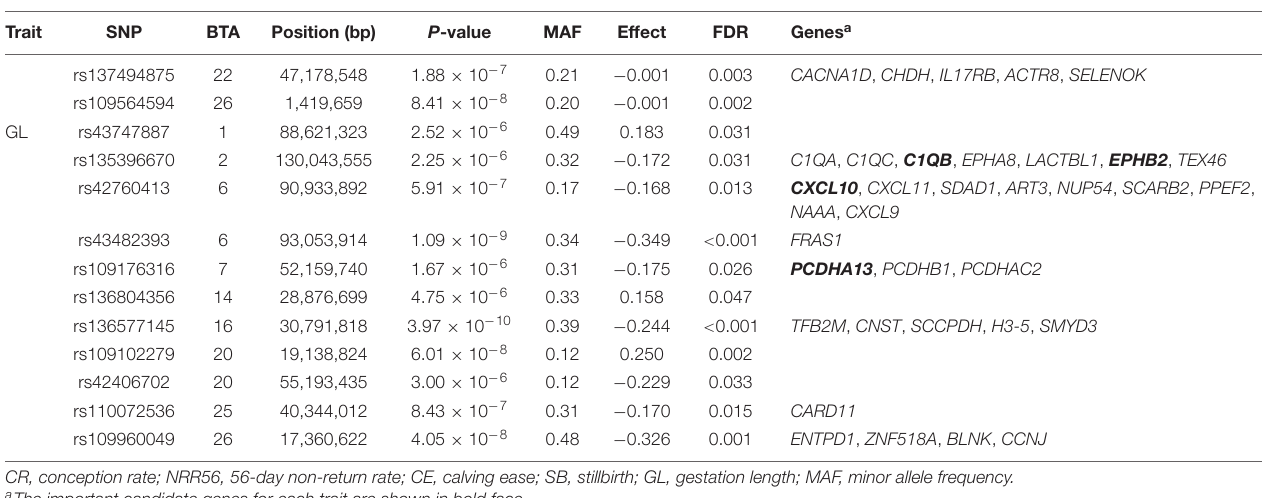
low heritability for SB and CE, though a moderate estimation was observed for GL. Except for the GED for SB (0.021 ± 0.002) and GL (0.116 ± 0.004), the repeatabilities were almost equal to the corresponding heritabilities. Each cow has only one calving record in each parity, which results in poor consistency among repeated data. The low heritability estimates of SB and CE indicate that these traits might benefit more from genomic information. A S-MGS model was used to evaluate calving traits in previous studies, which resulted in low heritability for CE